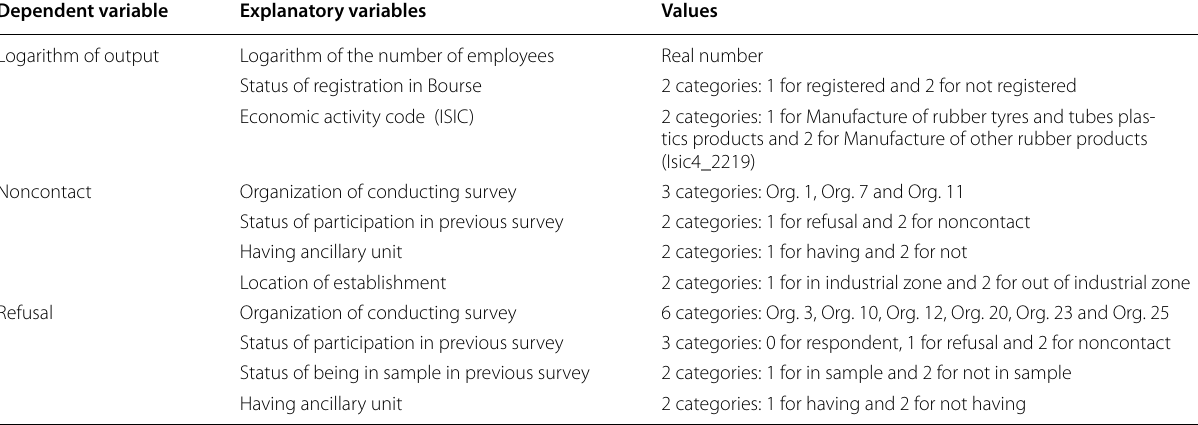
Table 5 Explanatory variables used in models for response and nonresponses